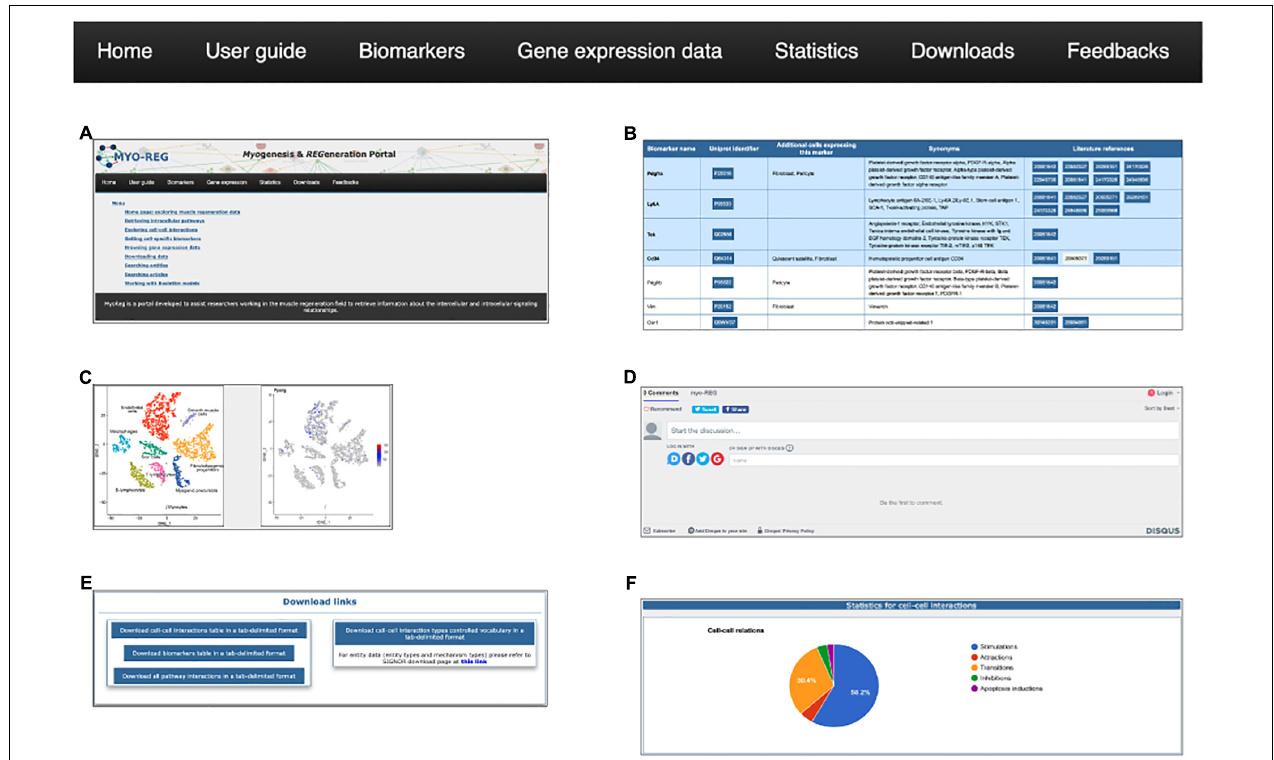
FIGURE 3 | The navigation toolbar. The navigation toolbar in the home page allows users to explore additional website content, including a short user-guide (A) , a list of cell type specific biomarkers (B) , gene expression data (C) , a feedback page (D) where users can suggest additions, modifications or corrections, a download page (E) for downloading information for local use and finally a statistics page (F)